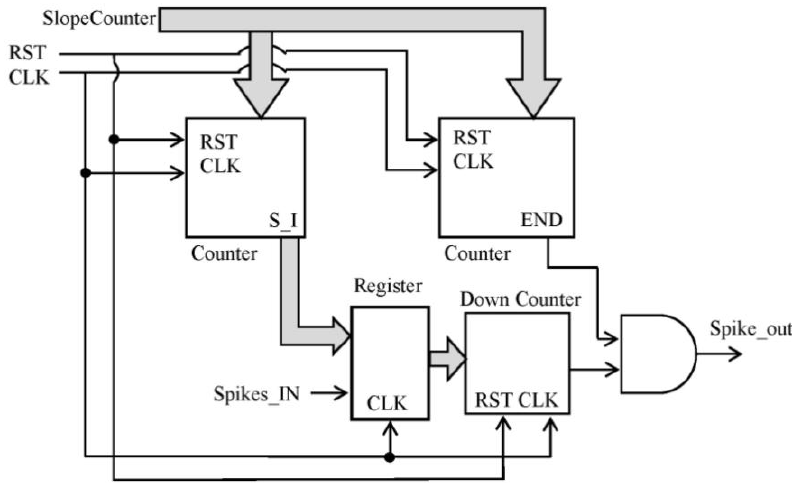
Figure 6. Block diagram generated for the block. It includes three counters: two of them are straight: one for the number of spikes to inject (S_I in the diagram) and another one for the life signal (it will produce the END signal to finish the movement); the last one is a decreasing counter in order to inject the accurate number of spikes.